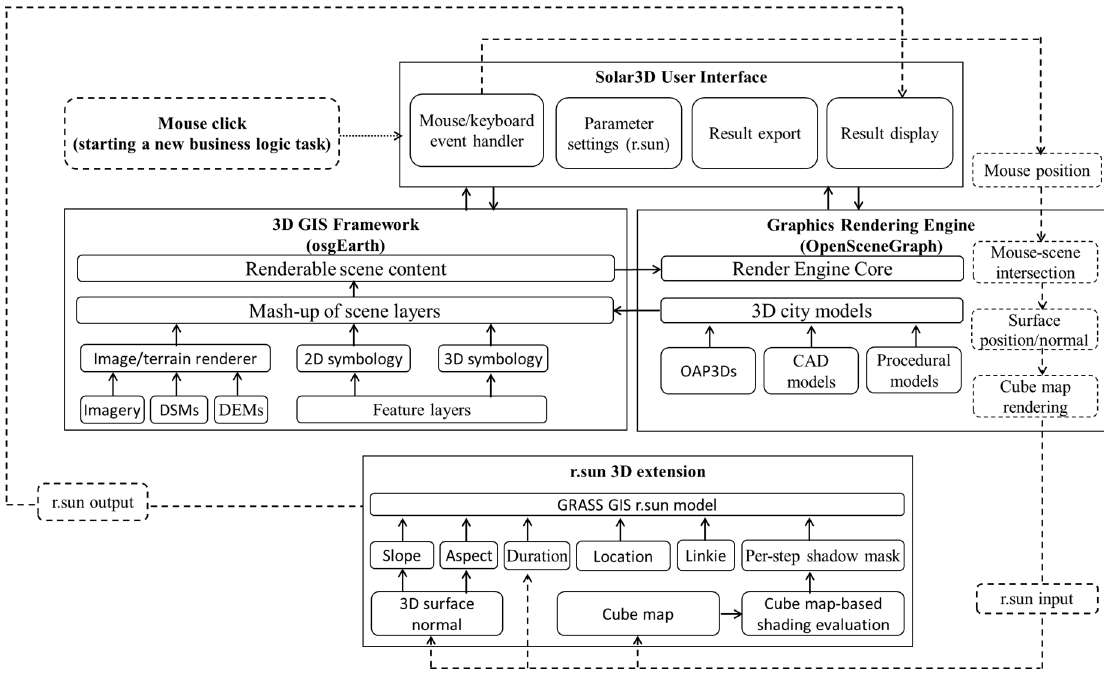
Figure 2. Solar3D architecture (solid boxes and arrows) and business logic (dashed boxes and arrows).